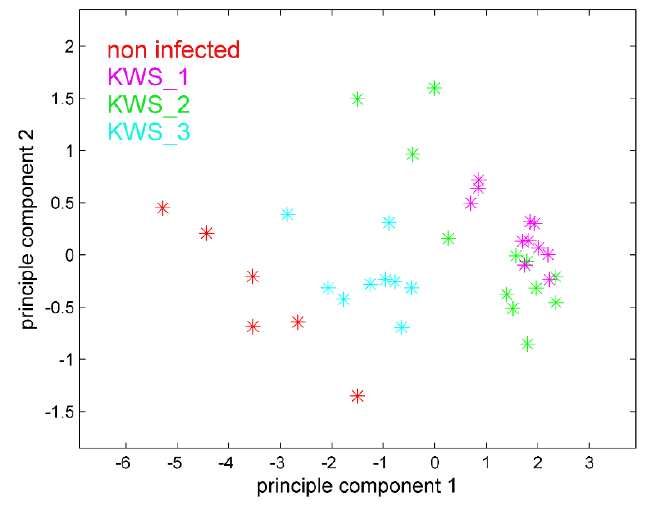
Figure 3. Principle component analysis of the spectral signatures from FieldSpec measurements of non-infected and infected (KWS_1, KWS_2, KWS_3) sugar beets. Evaluated spectral regions comprise 350–1350 nm and 1510–1800 nm. First principal component accounts for 92% of the spectral variance (7% in the second